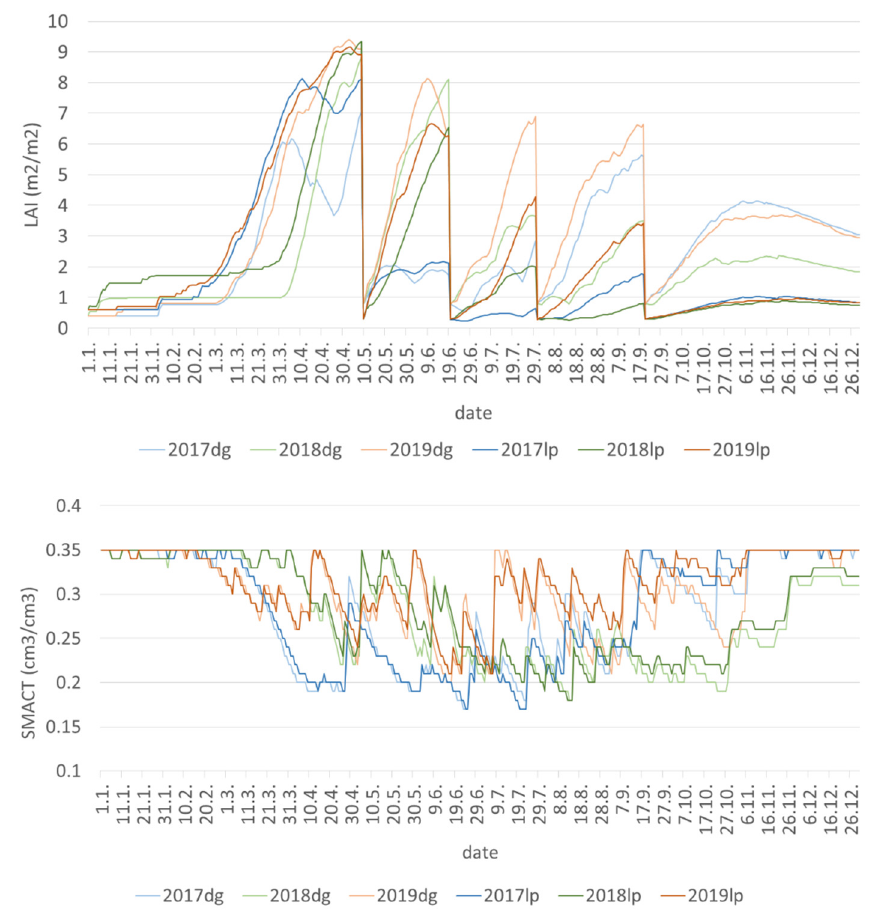
Figure 6. Daily values of LINGRA-N model results for the period 2017–2019 for Farm2 using parameter set calibrated for Dactylis glomerata in Jablje (dg) and Lolium perenne in Jablje (lp). ( Above ): leaf area index (LAI), ( below ): actual soil moisture (SMACT).